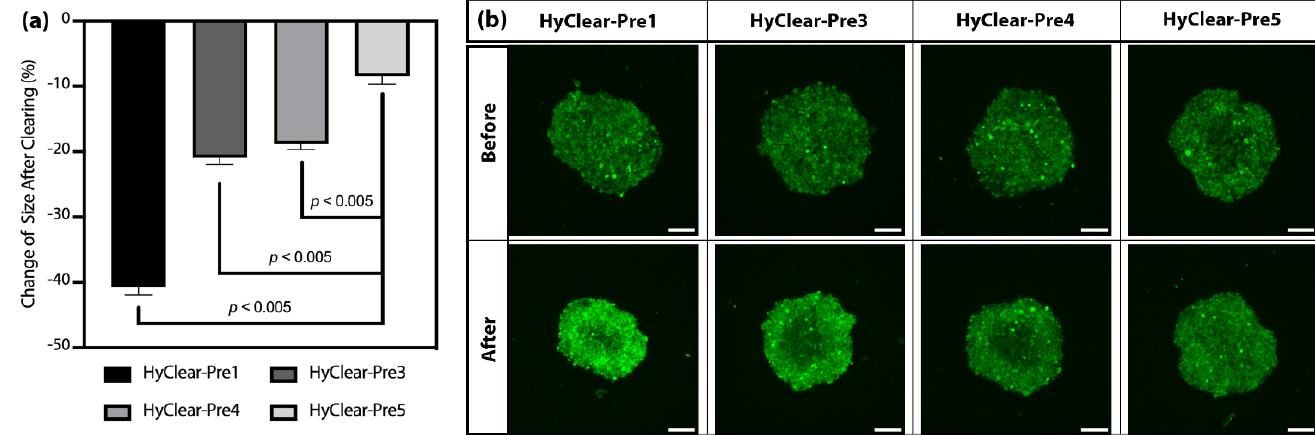
Figure 5. ( a ) The average change of the cross ‐ sectional area of the cross ‐ sectional images before and after clearing using HyClear with different concentrations of urea. ( b ) An example of the MIP image of the spheroids before and after tissue clearing using different concentrations of urea. The error bars represent the standard error of the mean of five to six replicates. The p ‐ values are calculated using a heteroscedastic two ‐ tailed t ‐ test. The scale bars represent 200 μ m.